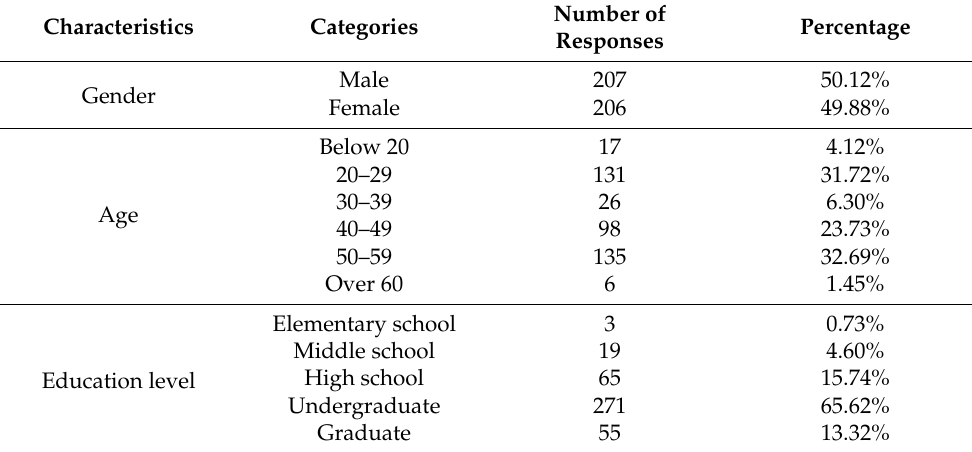
Table 2. Profile of respondents ( N =